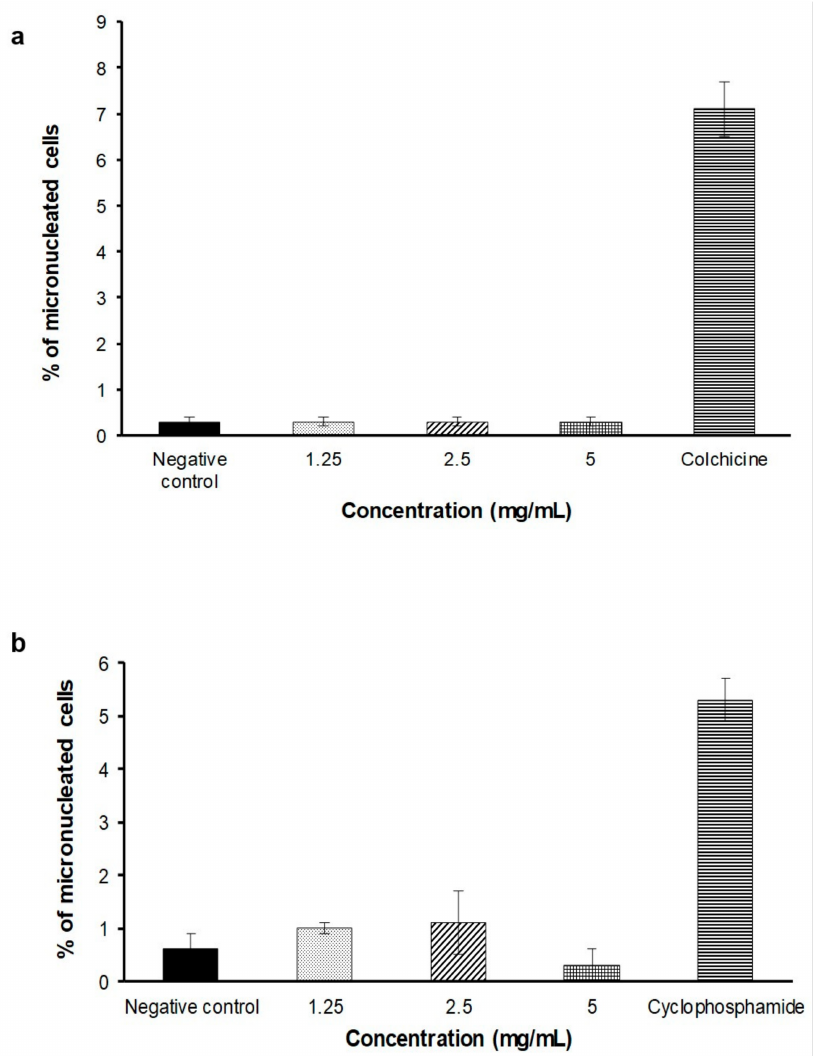
Figure 4. Percentage of micronucleated cells induced by different concentrations of FDAE or positive controls treated on V79B cells for 3 h with ( a ) and without ( b ) the presence of S9 metabolic activation. Data was expressed as mean ± SEM. Table 2. Mutagenicity testing of FDAE in the Salmonella typhimurium /microsome assay without S9 metabolic activation on TA100, TA1535, TA98, TA1537, and WP2 uvrA tester strains.